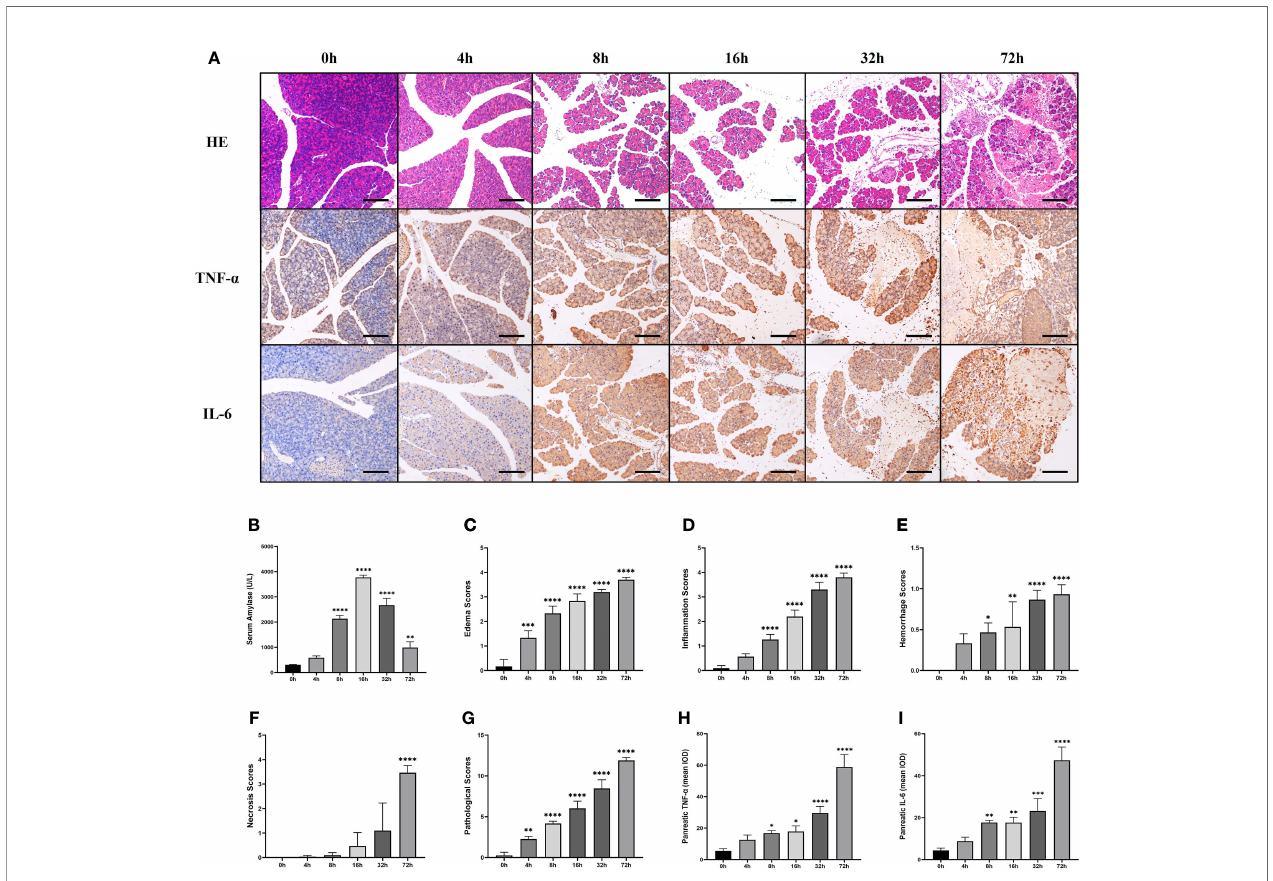
FIGURE 2 | The pancreas of mice presented signi fi cant lesions after ligation of pancreatic duct. Serum amylase level started to increase after 4h, peaked at 16h, and then gradually decreased. Pancreatic edema score, in fl ammation score, hemorrhage score, necrosis score as well as total score, and the expression of TNF- a and IL-6 were elevated over time and peaked at 72h. (A) HE staining and immunohistochemical staining of TNF- a and IL-6 of pancreas in mice. (B) Serum amylase. (C) Pancreatic edema score. (D) Pancreatic hemorrhage score. (E) Pancreatic hemorrhage scores. (F) Pancreatic necrosis scores. (G) Total pathological scores. (H) Mean IOD of pancreatic TNF- a . (I) Mean IOD of pancreatic IL-6. Values are shown as means ± SE. n = 3 per time point. *P < 0.05, **P < 0.01, ***P < 0.001, ****P < 0.0001 versus 0h. Scale bar=150 m m. IOD, integrated optical